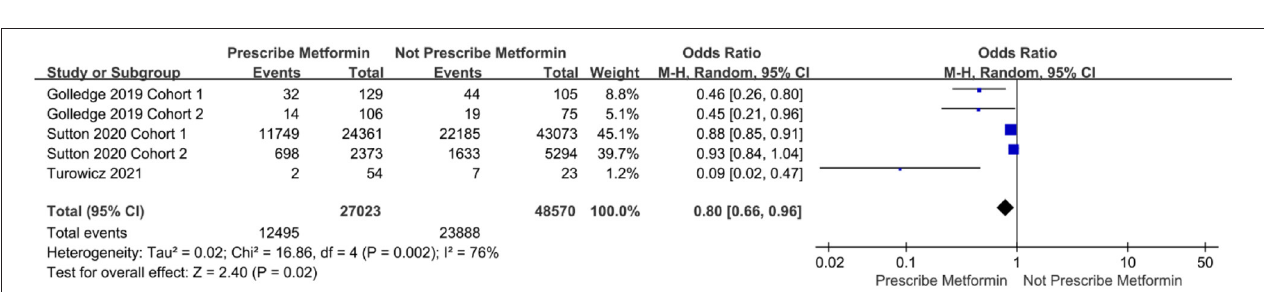
FIGURE 4 | Forest plot for AAA repair or AAA rupture-related